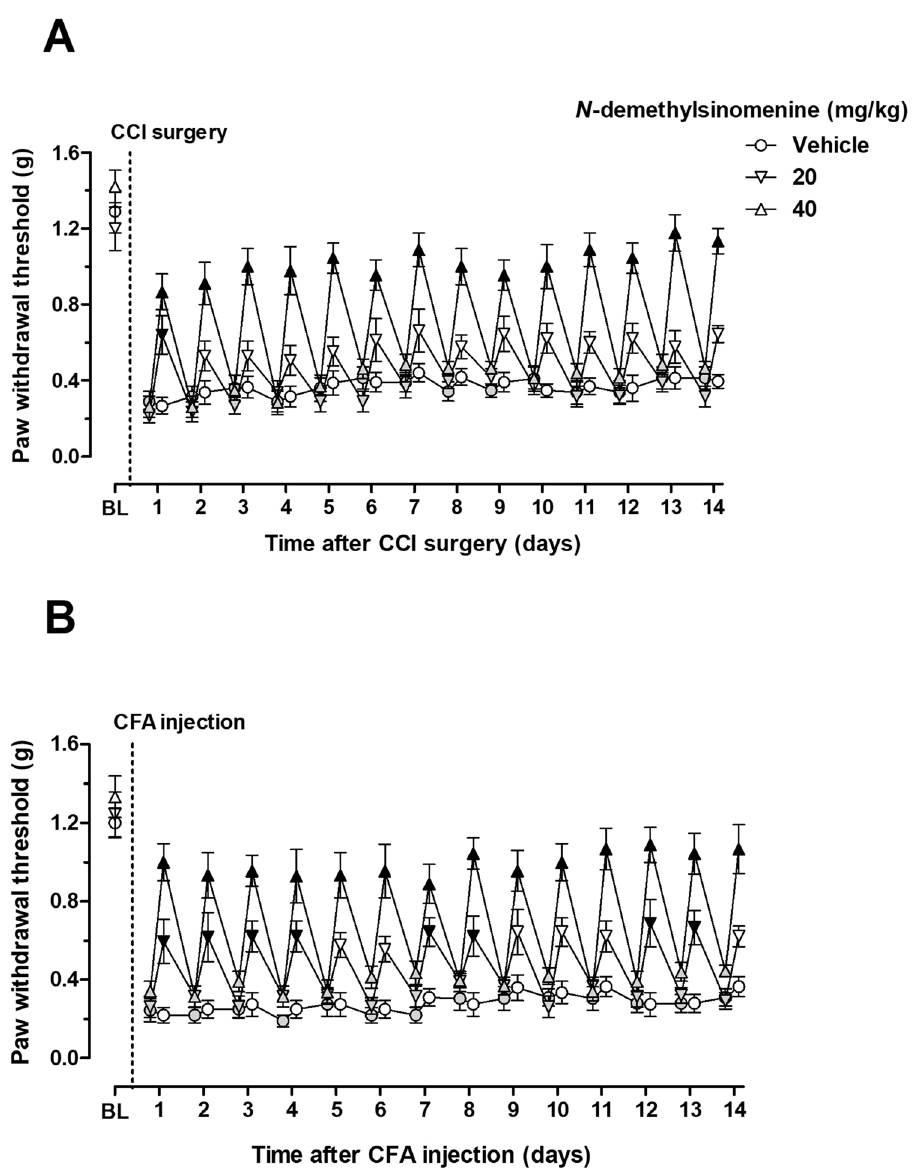
Figure 3. Effects of repeated N -demethylsinomenine treatment in CCI-operated ( A ) or CFA-treated ( B ) mice. Data were expressed as mean ± SEM (n = 8–9 per group), assessed by two-way ANOVA with repeated measures followed by Bonferroni post hoc analysis. BL: baseline value prior to CCI surgery or CFA injection; Filled grey symbols indicated the data prior to administration of N -demethylsinomenine each day during the period that mice received daily treatment. Filled black symbols indicated data significantly different from the corresponding vehicle group ( P <